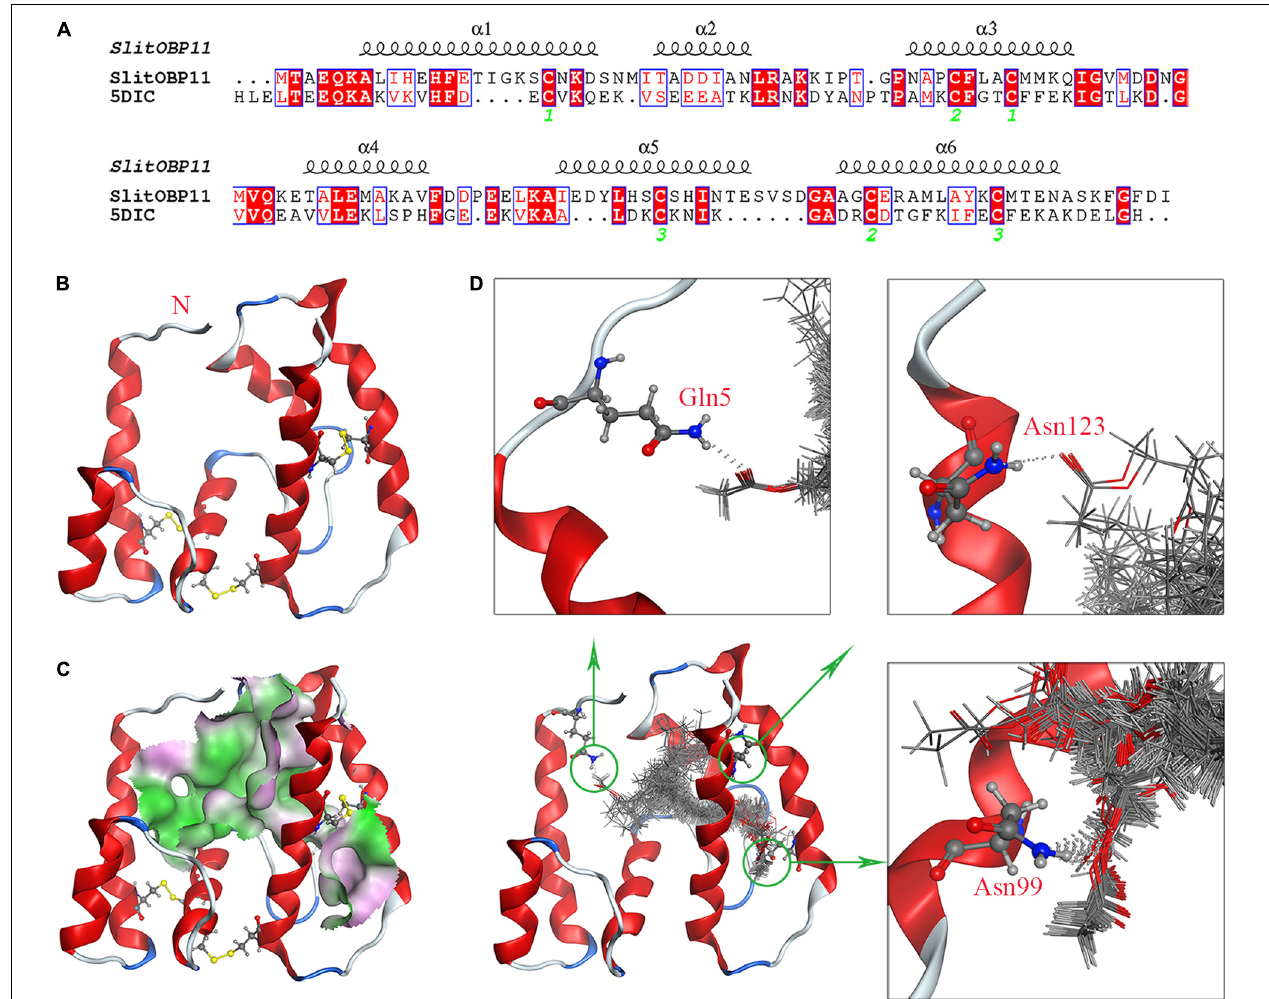
FIGURE 5 | Homology modeling and molecular docking of SlitOBP11. (A) Sequence alignment of SlitOBP11 and the template 5DIC. The secondary elements of SlitOBP11 are shown above the sequences. The green number showed the formation of disulfide bond. (B) Predicted 3D model of SlitOBP11. There are six Cys residues and three disulfide bridges between Cys residues Cys20-Cys52 and Cys48-Cys110 and Cys95-Cys119, which form six α -helix. (C) An open cavity of SlitOBP11 at the center of the protein core. The green areas express hydrophobicity and red areas express hydrophilia of binding cavity. (D) Predicted formation of hydrogen bond between cavity and ligands. Three hydrophilic residues Gln5, Asn99, and Asn123 form the polar surface of the cavity. The red atom is oxygen atom. The blue atom is nitrogen-atom. The gray molecules in the cavity different